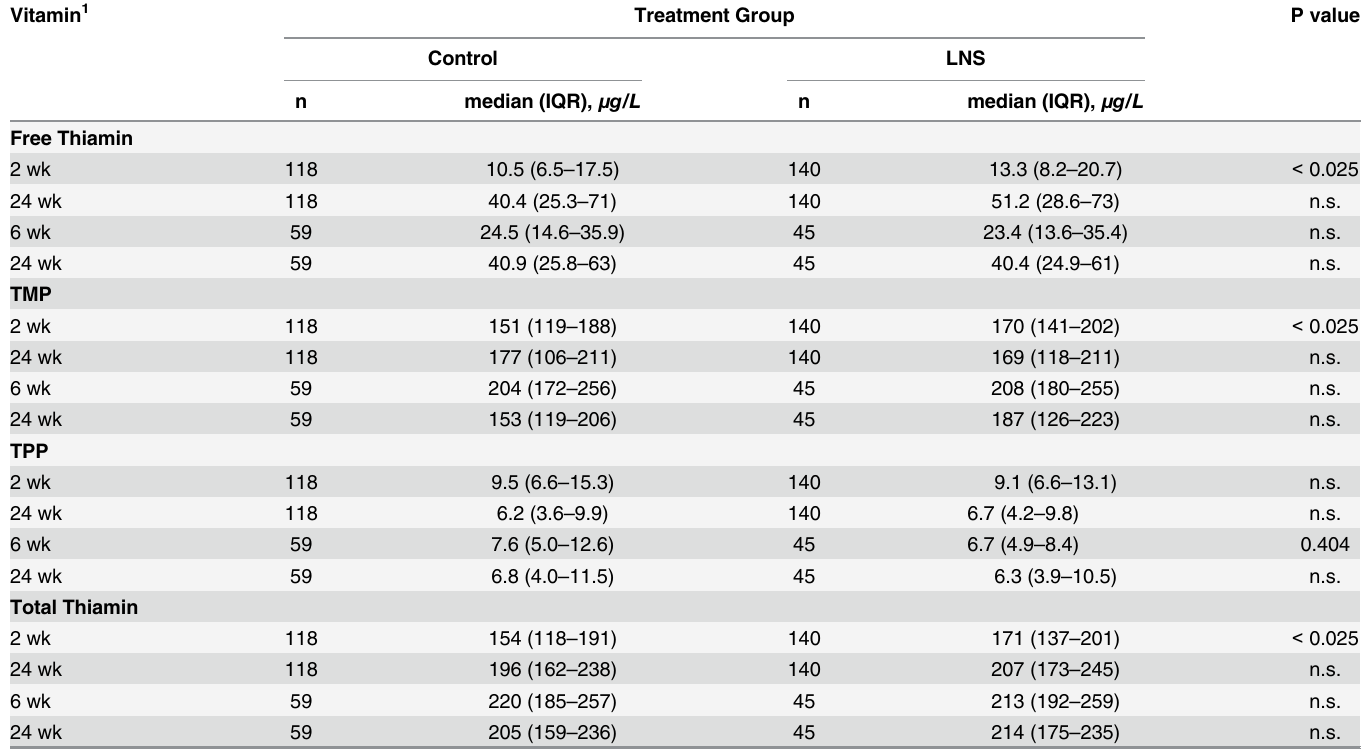
Table 4. Median concentration and interquartile range (IQR) of free thiamin, TMP, TPP, and total thiamin in breast milk of BAN study women assigned to one of two treatment arms within the two subgroups (initial sample at 2 or 6 weeks). Vitamin 1 Treatment Group P value